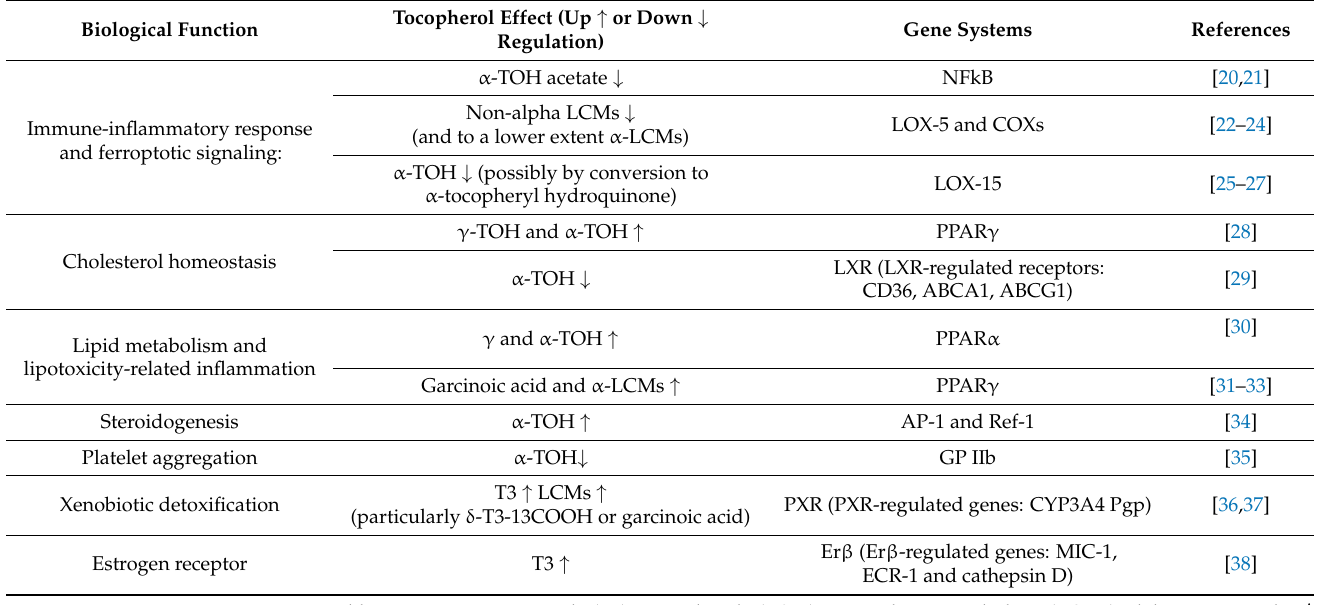
Table 1. Some molecular targets and gene response systems under the influence of α -tocopherol (vitamin E) and its analogues and endogenous metabolites.